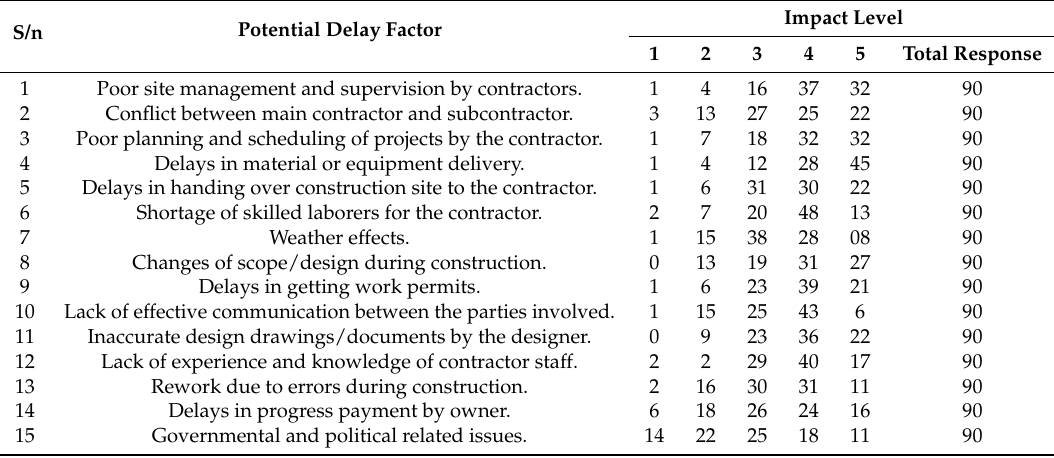
Table 2. The raw data for the Relative Importance Index